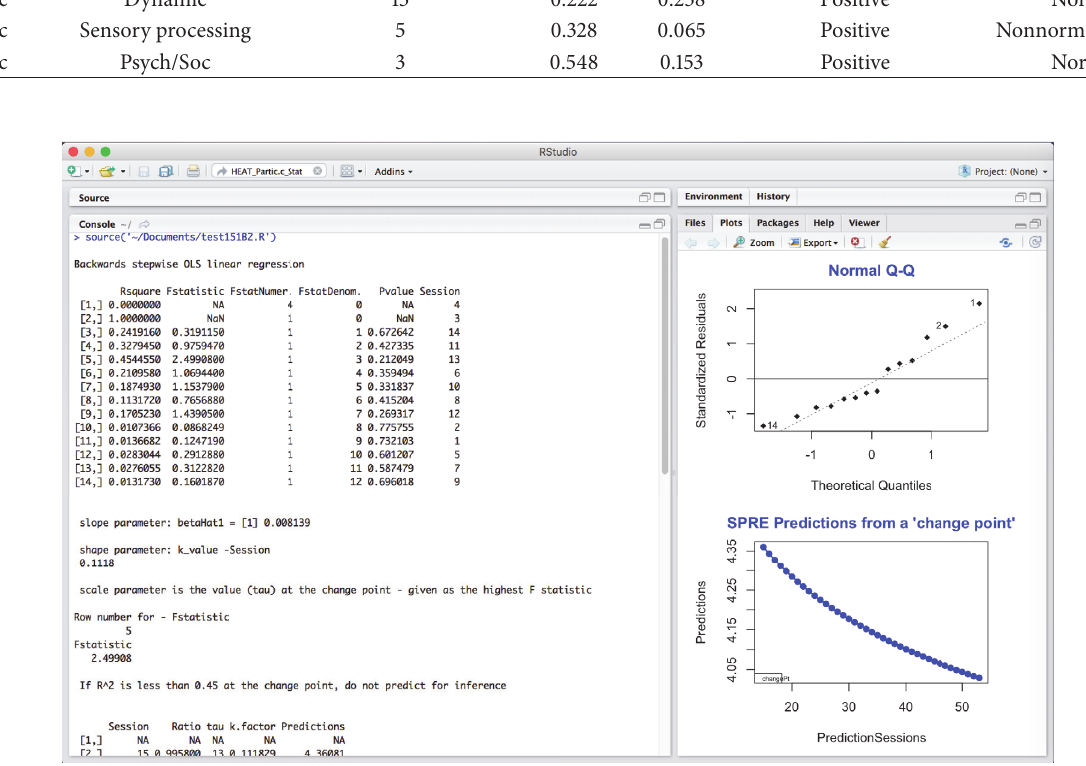
Figure 3: HEAT standardized residuals analysis for Partic.c Static posture in SPRE.